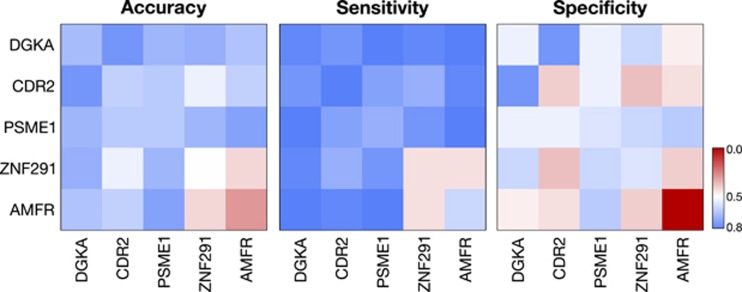
Combinations of RNA measurements have high predictive power, though individual measurements can be non-predictive. The heat maps contain the cross-validated accuracy, specificity, and sensitivity of pairwise combinations of the top five predictive transcripts from backward selection with linear SVMs. Even though AMFR had high predictive value for classifying MDD in conjunction with other variables, it had no predictive power on its own, as demonstrated by a specificity of 0%. Combinations of transcripts can inform a useful SVM boundary even if single transcripts have no ability in isolation, suggesting that depression is associated with combinations of genes. Note that backward selection does not comprehensively explore all transcript combinations and the complex relationships among transcripts suggest that a more predictive combination may still remain. MDD, major depressive disorder; SVM, support vector machine.